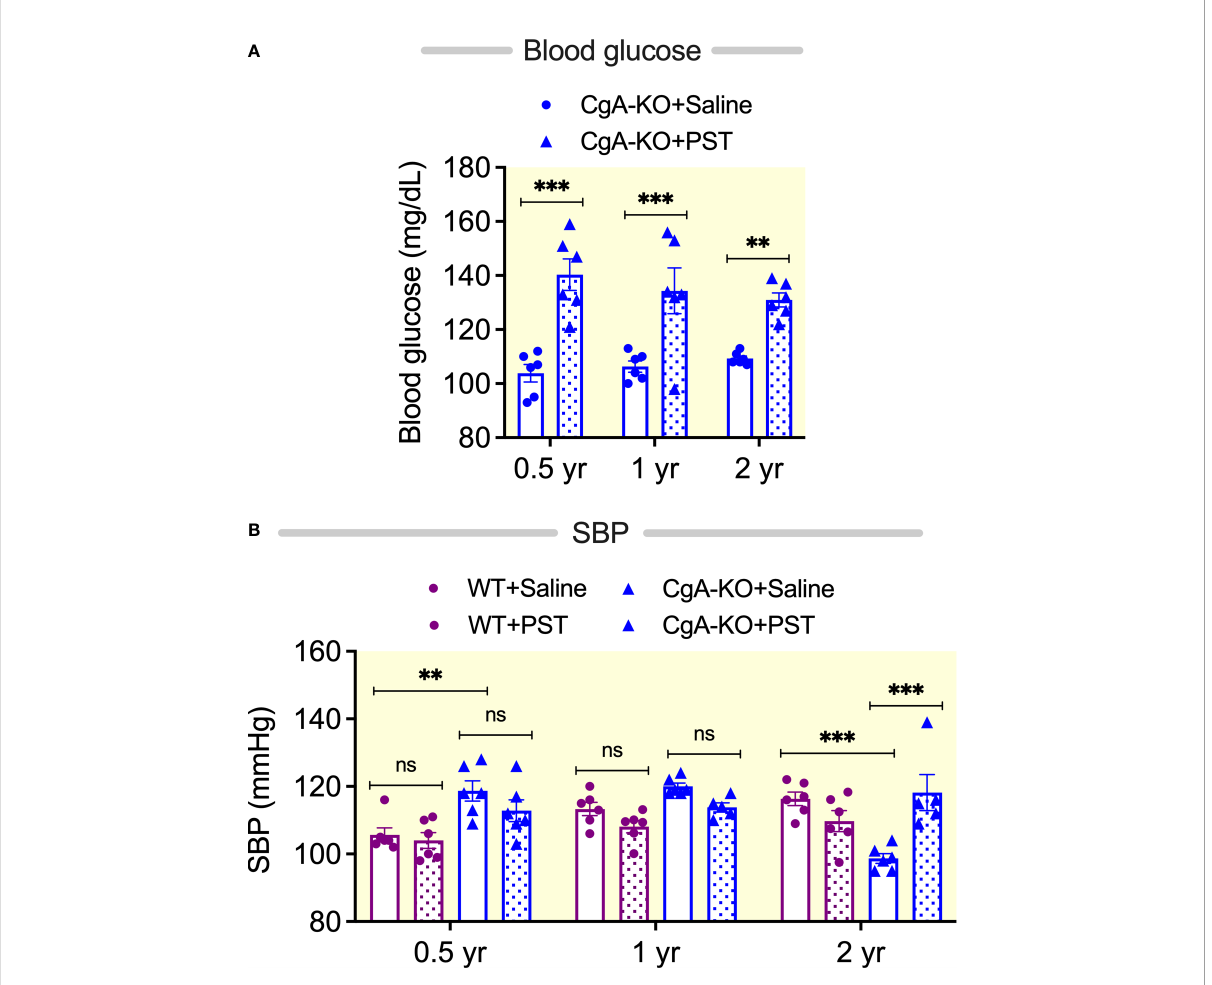
FIGURE 9 PST-induced changes in blood glucose and blood pressure. PST increases blood glucose in CgA-KO mice. (A) Blood glucose in PST (2 µg/g BW for 30 days intraperitoneal injection)-treated mice. 2-way ANOVA: Interaction: ns; Age: ns; Genotype & Treatment: p < 0.001. PST increases SBP in aging CgA-KO mice. (B) SBP in PST-treated mice. 3-way ANOVA: Age: ns; Genotype: p < 0.01; Treatment: ns; Age: x Genotype: p < 0.001; Age: x; Treatment: p < 0.01; Genotype: x; Treatment: p < 0.05; Age x; Genotype: x; Treatment: p < 0.001. **P < 0.01; ***P <